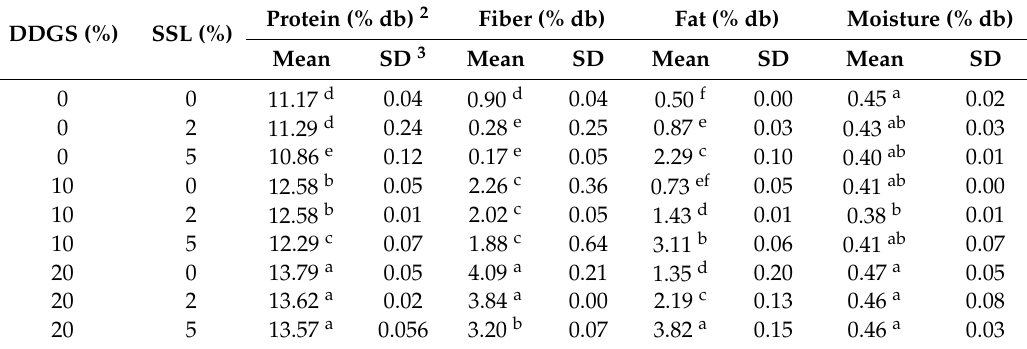
Table 3. Treatment effects on chemical properties of baked breads 1